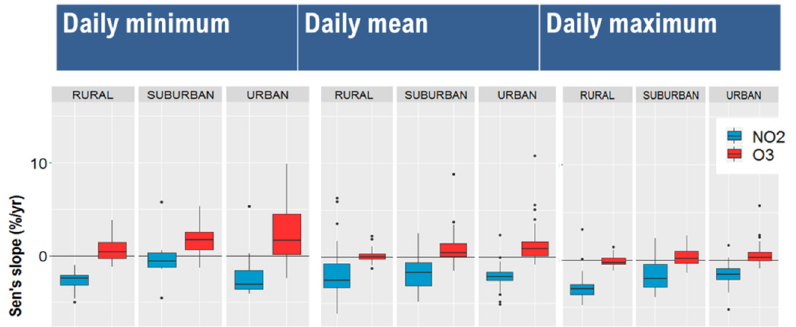
Figure 13. Box plots showing the slope of the trends of daily minimum, daily mean, and daily maximum concentrations observed during the period 2002–2018 for all stations meeting the data coverage criteria. O 3 (red) has mostly positive slopes, indicating an increase for this period, whereas the trends of NO 2 (blue) are mostly negative, indicating decreases in NO 2 concentrations.